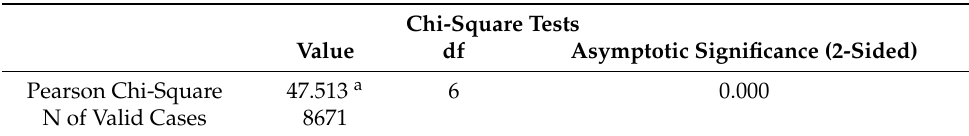
Table 7. Chi-square test (enterprise size vs. change in the ROA 2019 profitability indicator). Source: own research.